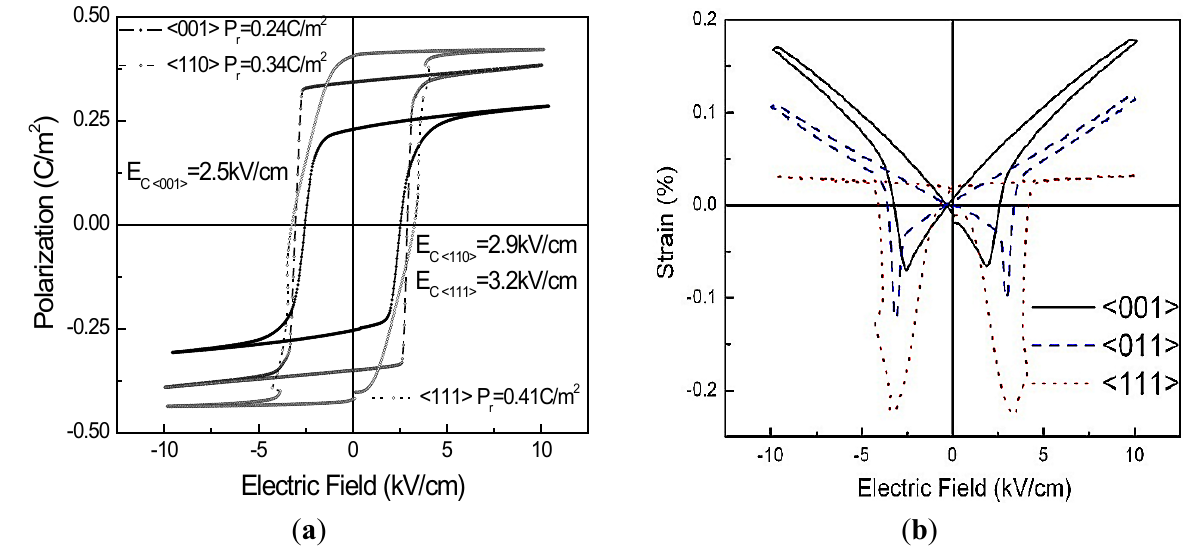
Figure 5. Polarization hysteresis for PMN-30% PT crystals along crystallographic orientations <001>, <110> and <111>. Reprinted with permission from [61].